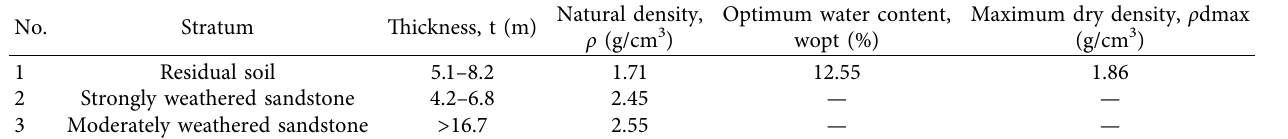
Table 1: Physical properties of the soil and bedrocks.